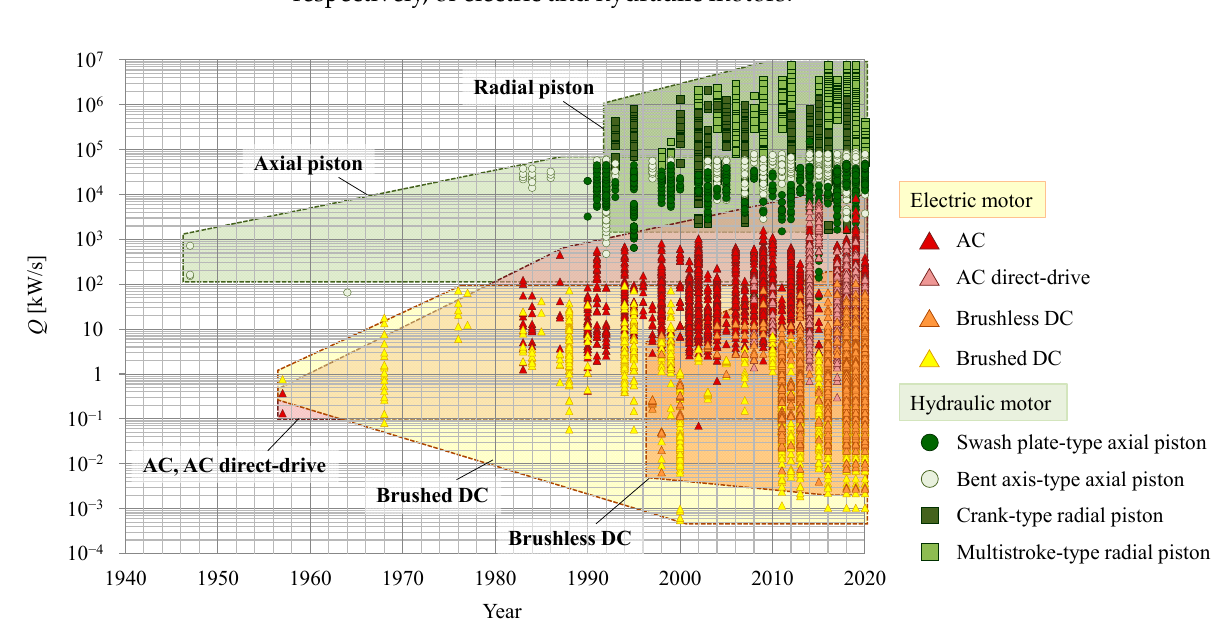
Figure 7. Transition of power rate density. The power rate of hydraulic motors has not changed significantly with time, alt- hough that of radial piston motors has increased slightly. On the other hand, the power rate of electric motors has tended to increase, with the exception of DC motors. Moreover, differences in the transitions between hydraulic and electric motors become clearer when compared by power rate density. Although the power rate density of hydraulic motors has remained higher than that of electric motors for many years, the increased power rate density of electric motors is higher than that of hydraulic motors. It can be inferred that the improved performance of permanent magnets has also contributed to the increased power rate density in electric motors. The maximum power rate density of hydraulic mo- tors is an order of magnitude greater than that of electric motors, but the power rate den- sity of hydraulic motors has not changed since the 1990s. Therefore, the difference be- tween these types of motor may be smaller in the future.